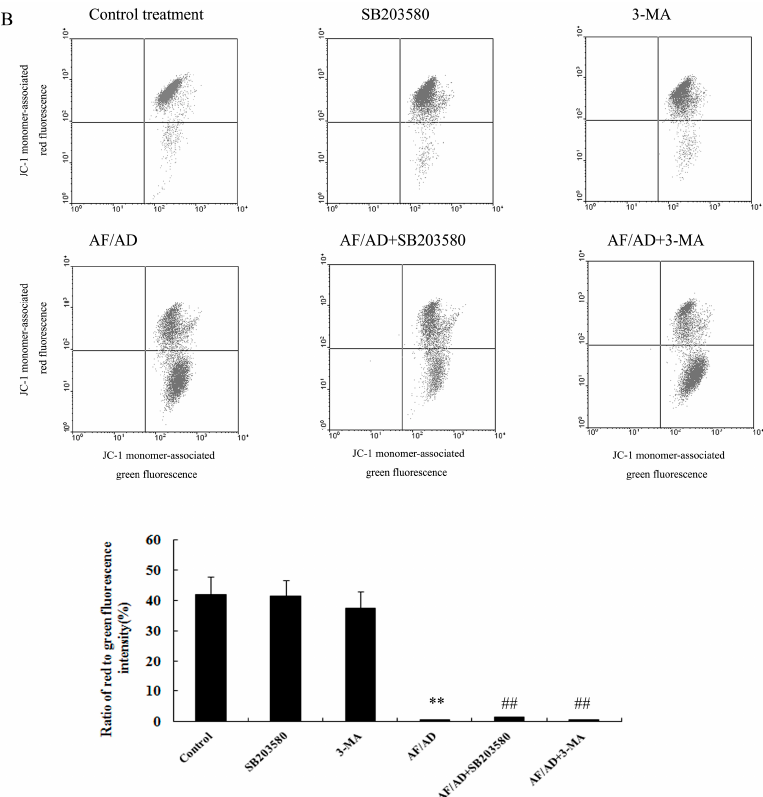
Figure 5. Effect of AF/AD on ∆Ψ m of Bel-7402 cells with or without SB203580 or 3-MA. Bel-7402 cells were pretreated with AF (6 µ M)/AD (20 µ M) in the absence or presence of SB203580 (10 µ M) or 3-MA (5 mM) for 24 h. Red/green fluorescence intensity was detected by JC-1 assay of fluorescence microscope ( A ), and ratio of red to green fluorescence intensity was analyzed by JC-1 assay of flow cytometry ( B ). Values presented are representative of three independent experiments (means ± S.D.; ** p < 0.01, compared with control treatment; ## p < 0.01, compared with AF/AD treatment).